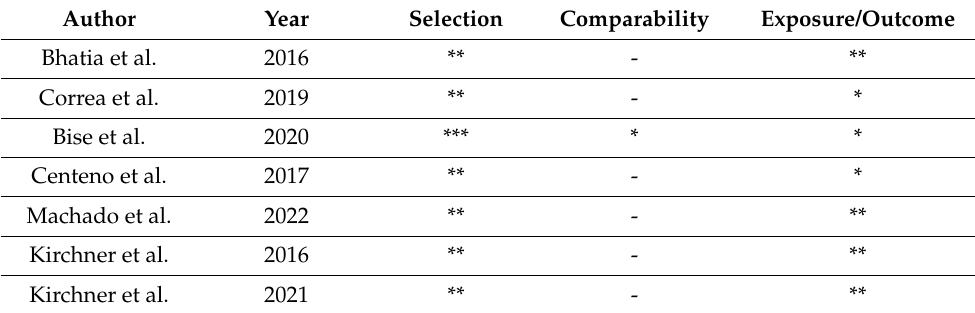
Table 2. Quality rating for the non-RCT studies.